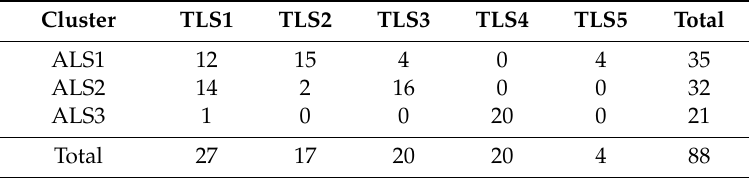
Figure 5. Illustration of canopy structural type groupings derived from hierarchical agglomerative clustering overlaid on non-metric multidimensional scaling ordination of structural diversity across seven studied forest sites; ( a ) illustrates cluster groups derived from aerial laser scanning (ALS) data and ( b ) cluster groups from terrestrial laser scanning (TLS) data. Table 5. Comparison of plot assignment to groupings derived from hierarchical agglomerative clustering of aerial laser scanning (ALS) and terrestrial laser scanning (TLS), illustrating structural diversity variation in multivariate space between LiDAR platforms. Cluster name indicates which plot was assigned to a given TLS or ALS cluster. Numbers indicate how many plots were assigned to each cluster.